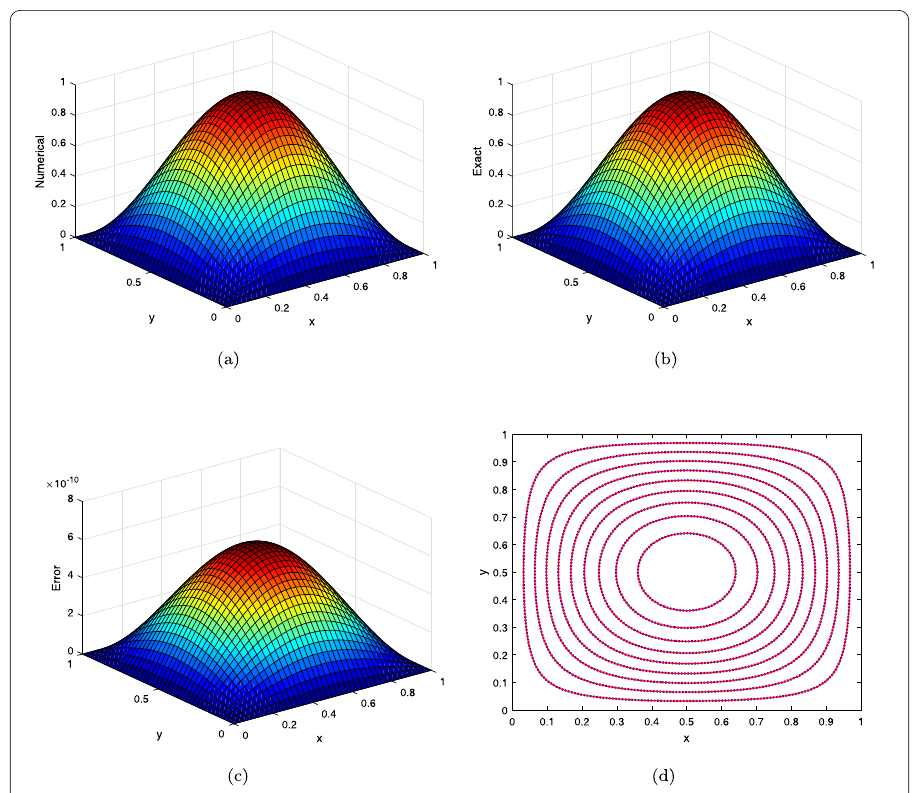
Figure 2 ( a ) The numerical solution, ( b ) the exact solution, ( c ) the absolute error, and ( d ) the contour plots of the numerical solution and exact solution with τ = 0.0002, t = 0.02, N = 40, respectively, for Problem